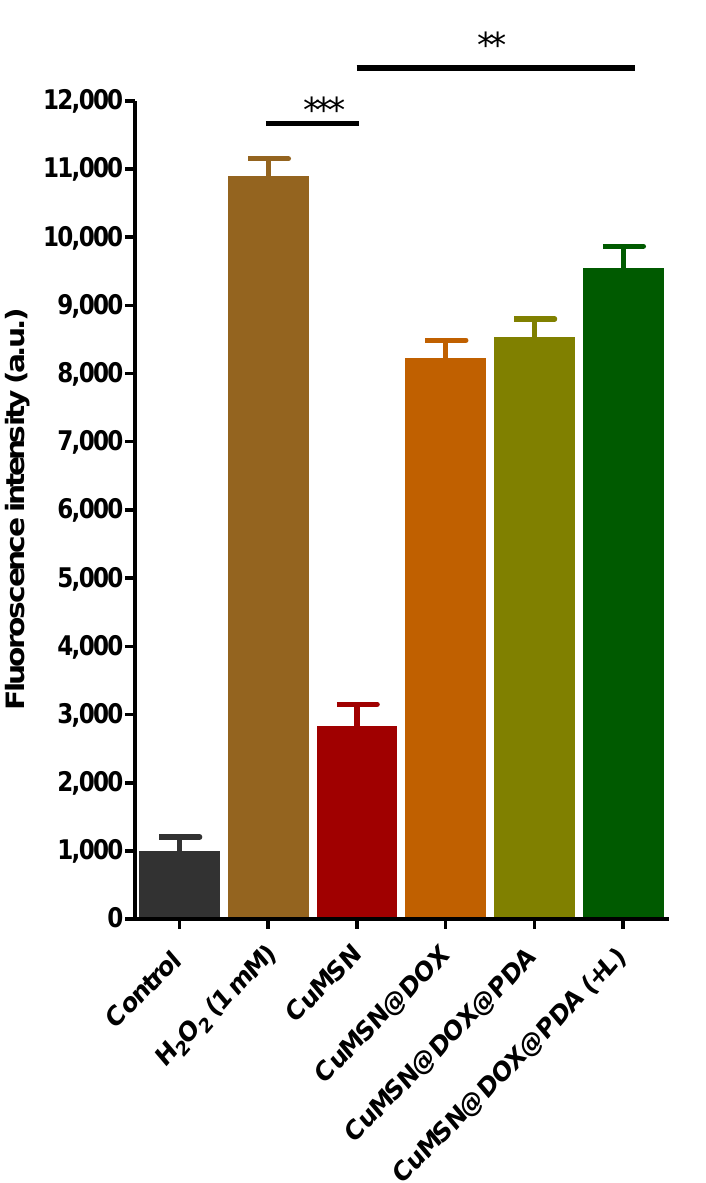
Figure 7. Intracellular ROS production in A549 cells treated with nanoparticles with and without light irradiation by DCFDA assay. The fluorescence signal was detected by a microplate reader ( λ ex = 488 nm, λ em = 535 nm). ***, and ** denotes the significant difference between H2O2 vs CuMSN and CuMSN vs CuMSN@DOX@PDA (+L).